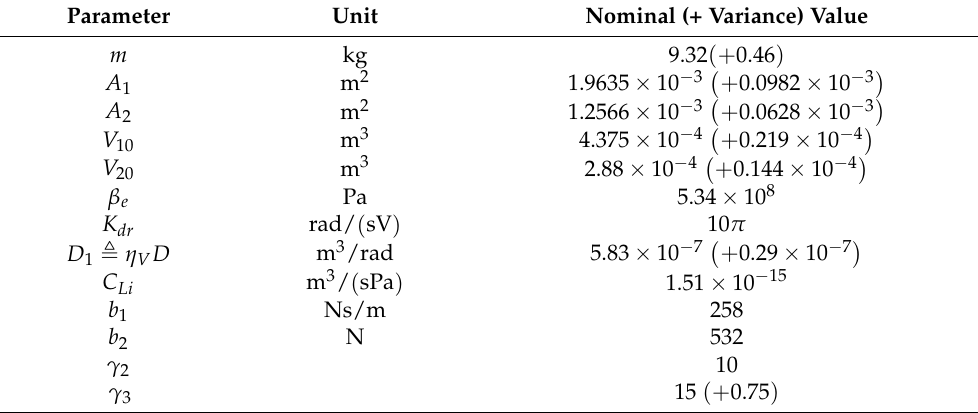
Table 4. Nominal values of the EHA system parameters.